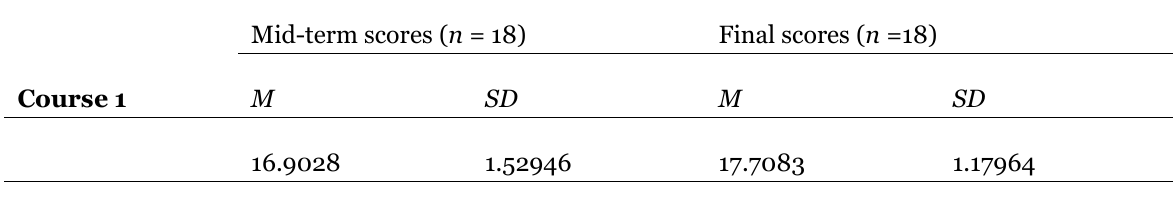
Test of normality Shapiro-Wilk = 0.958 p = 0.182